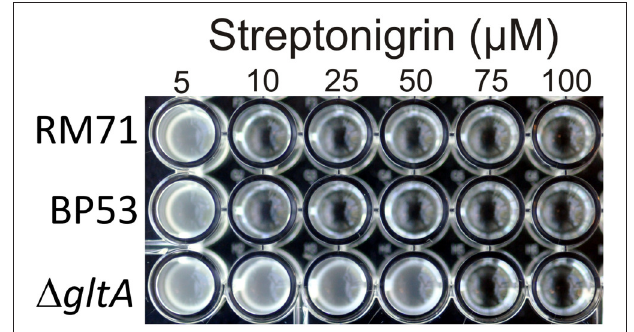
FIGURE 5 | Growth of RM71 and mutants BP53 and RM71 ∆ gltA in presence of different concentrations (from 5 to 100 µ M) of the iron-dependent antibiotic streptonigrin. Picture shows growth in a 96-well microtiter plate.